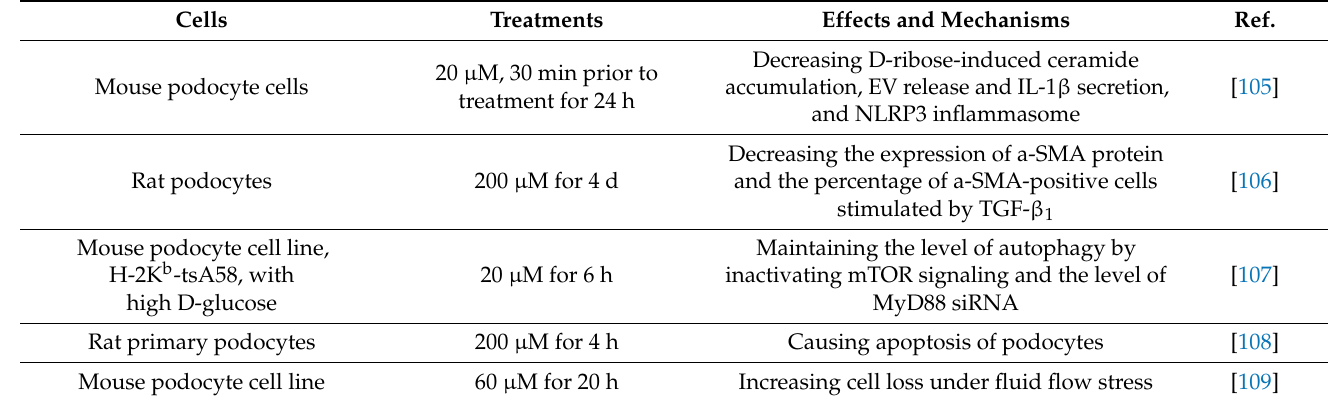
Table 2. The effects of genistein on podocytes in animal